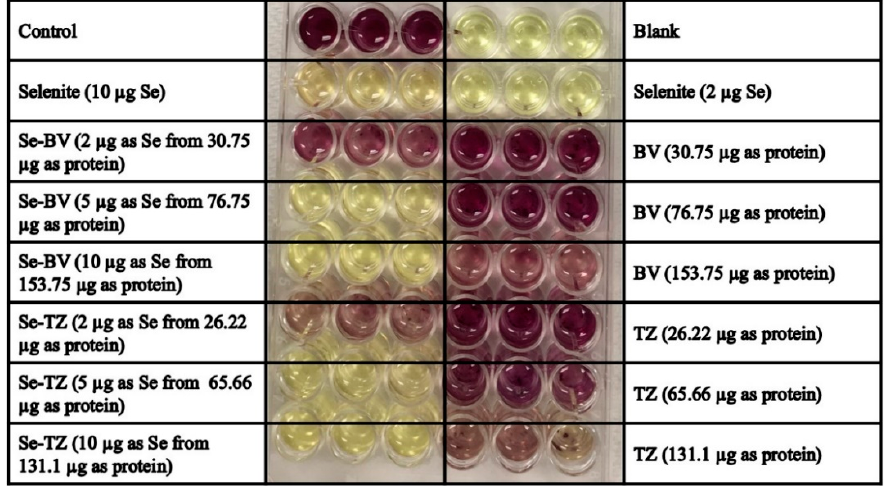
Figure A2. HME50-5E MTT Plate Photo on Day 4 Post Treatment showing the insoluble formazan salt.